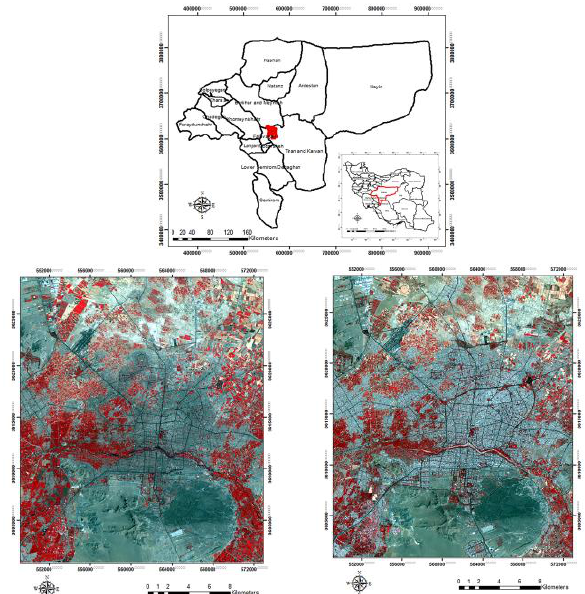
Figure 1. False color composite images demonstrating